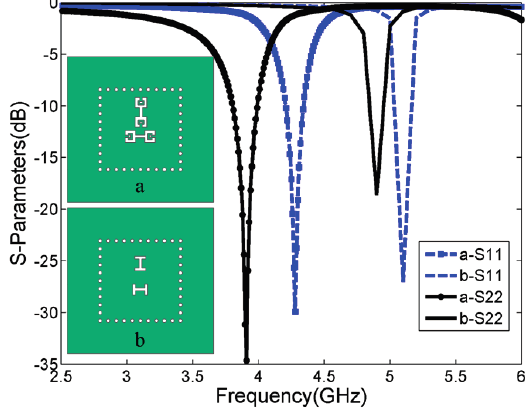
Figure 2. Simulated return loss with different coupling